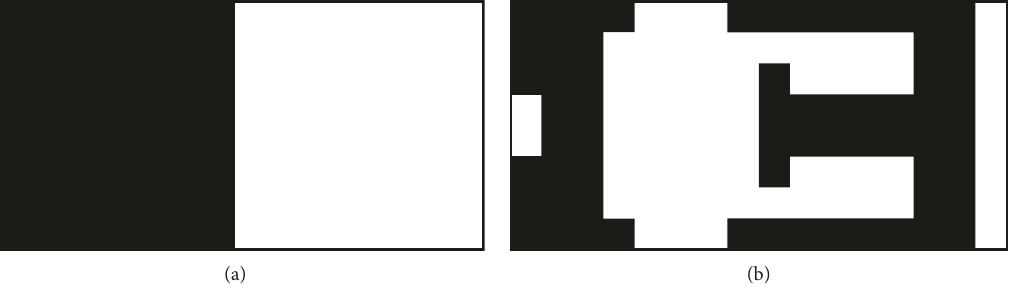
Figure 3: The optimal layouts of CLD treatment. (a) f